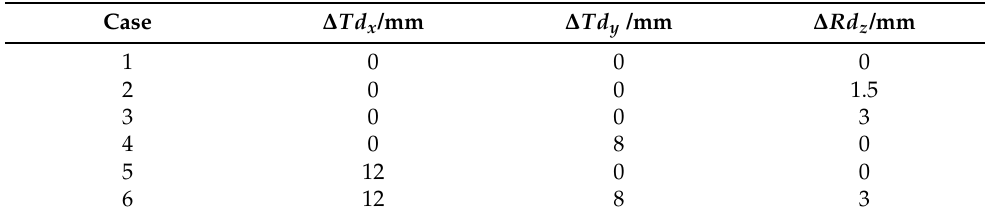
Figure 3. CT Model. ( a ) CT 3D Model. ( b ) Slices of the CT model at Td y = − 29.02 mm. Table 1. Geometric